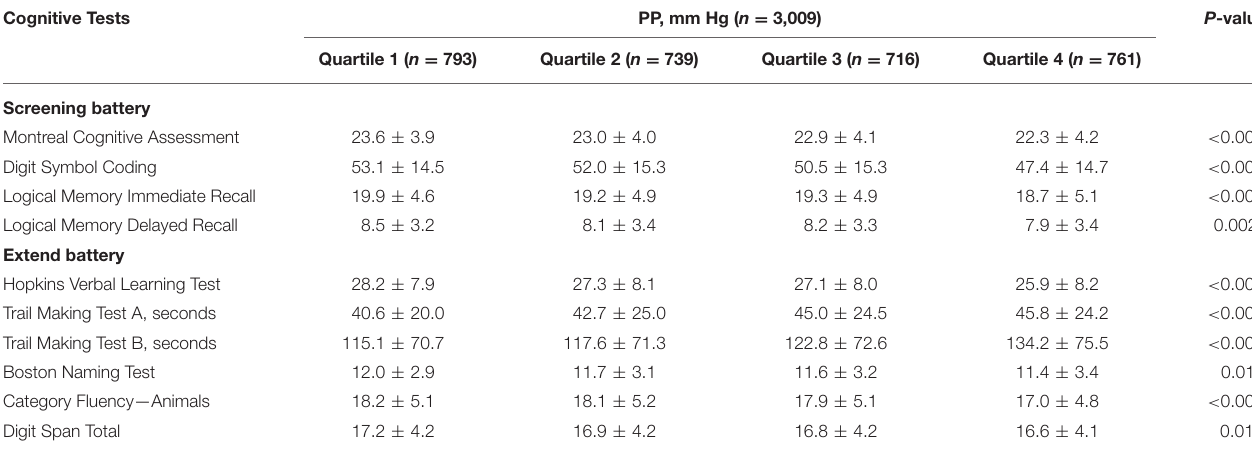
TABLE 2 | Performance on cognitive tests by PP quartile in SPRINT-MIND participants. Cognitive Tests